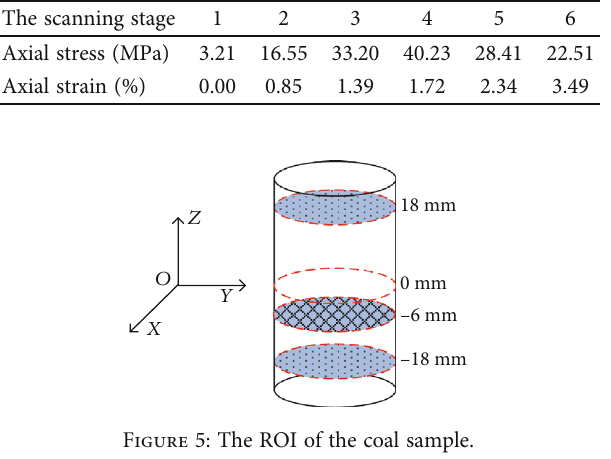
Table 2: The scanning stage of the coal sample.